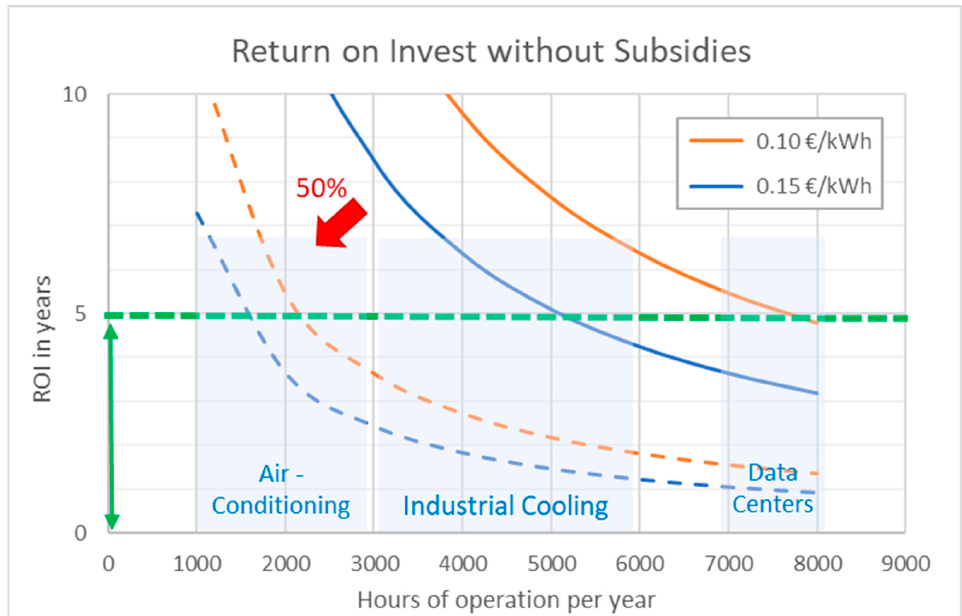
Figure 3. ROI study for adsorption chillers. Green line ROI of 5 years.